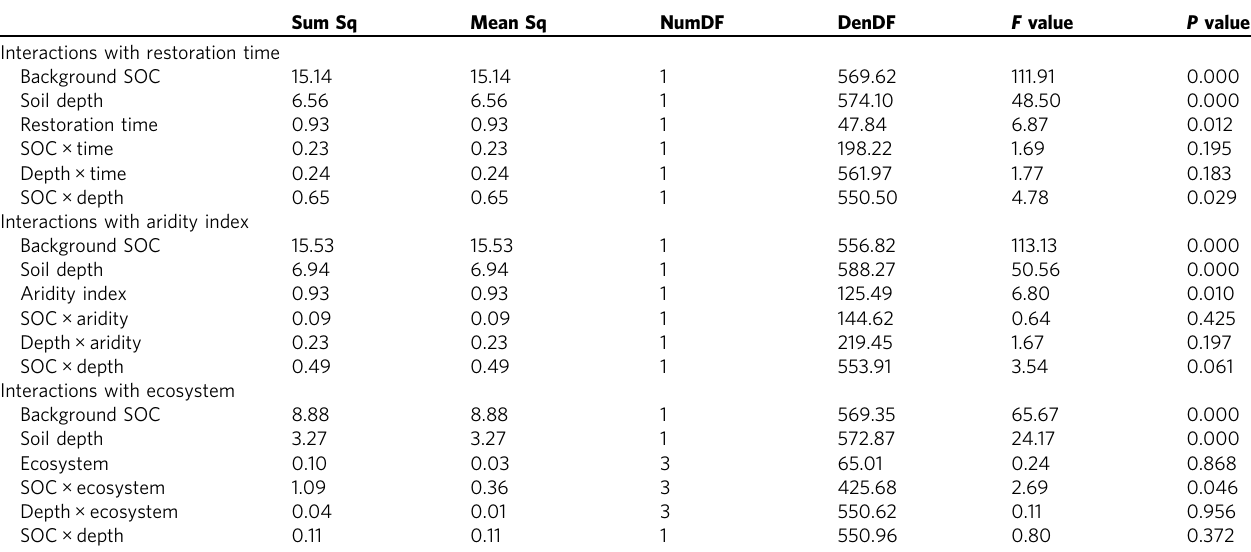
Table 1 Interaction effects of background SOC or soil depth with restoration time/aridity index/ecosystem type on the difference between active and natural carbon restoration. Sum Sq Mean Sq NumDF DenDF F value P